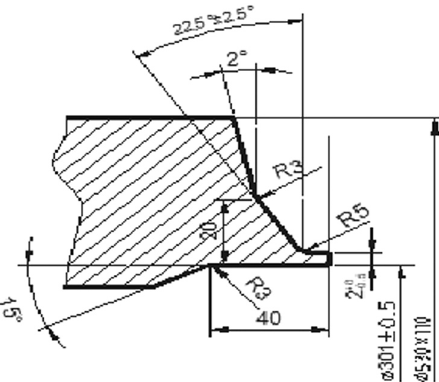
Figure 2: Schematic diagram of welding groove of thick wall 08Cr9W3Co3VNbCuBN steel pipe.